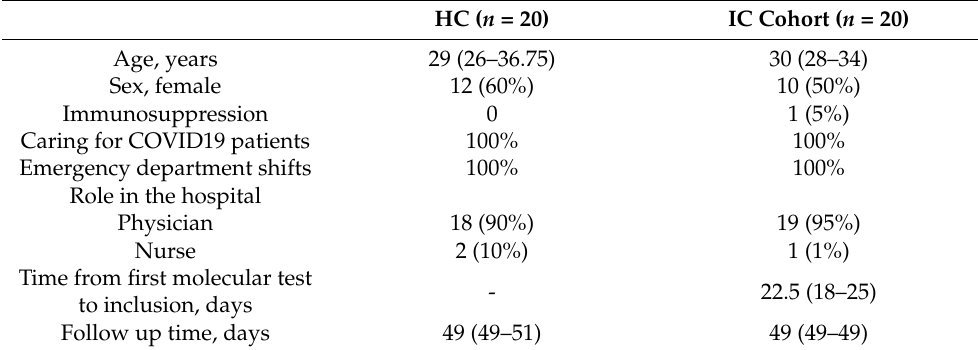
Table 1. Demographic characteristics of the